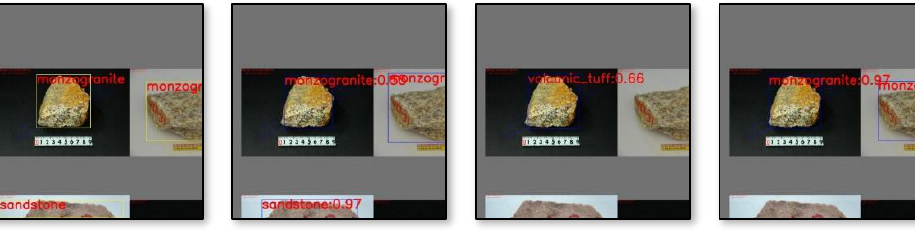
Figure 16. Comparison of detection results of part test datasets. ( a , e ) show the labeled ground-truth of targets. ( b , f ) is the detection result obtained by using improved method in this paper (RDNet+Aug). ( c , g ) is the detection result of Faster R-CNN method. ( d , h ) is the detection result of SSD method.